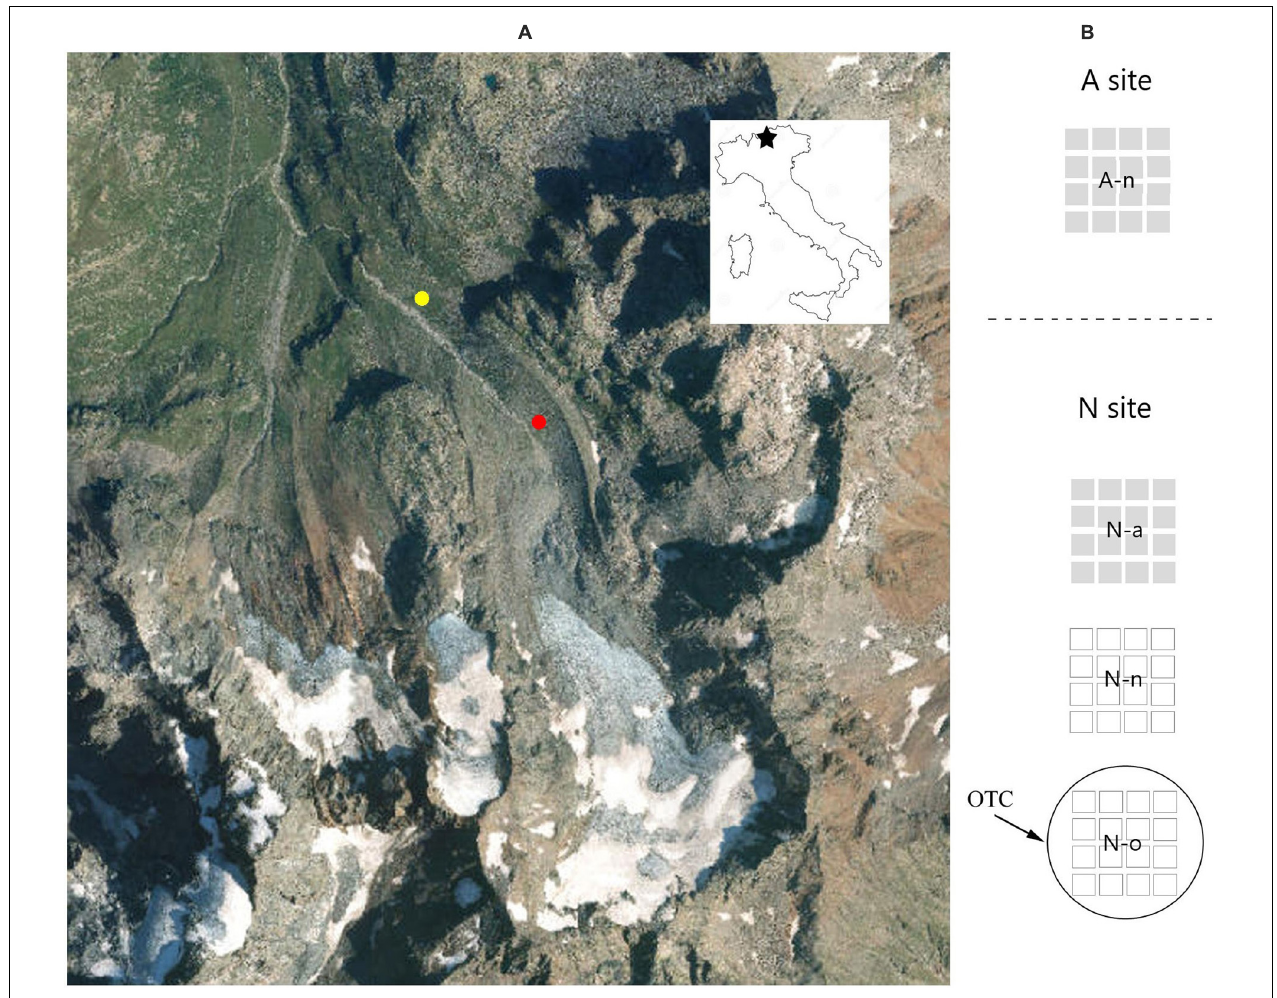
FIGURE 1 | Study area and experimental design: (A) study area showing the location of the two experimental sites at the alpine vegetation belts (site A, 2,300 m a.s.l., yellow) and at the nival vegetation belts (site N, 2,500 m a.s.l., red); (B) schematic illustration of the 20 pots arranged at the A site on its natural soil (A-n) and the 60 pots at the N site, with one group on its natural soil (N-n), another with soil from A (N-a) and another heated by an OTC (N-o).